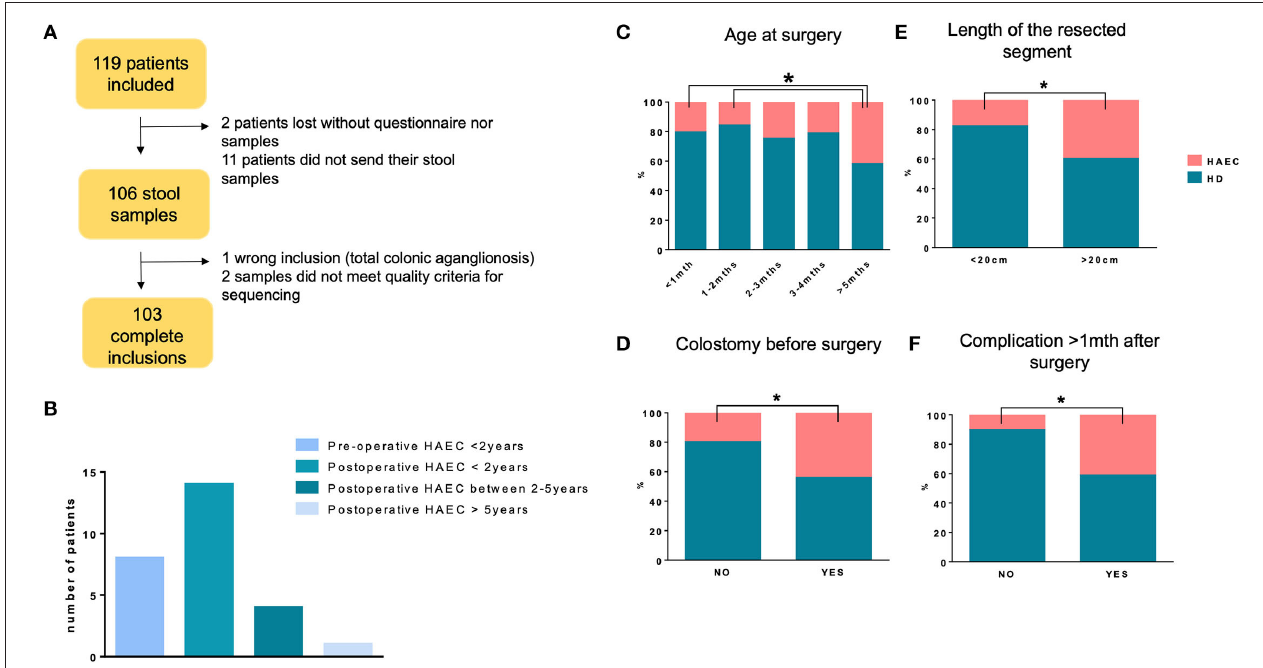
FIGURE 1 | MICROPRUNG cohort characteristics. Flowchart of the cohort (A) , Hirschsprung-associated enterocolitis incidence as a function of age (B) , age at surgery (C) , existence of colostomy before surgery (D) , length of the resected segment (E) , and occurrence of complications more than 1 month after surgery (F) . * P < 0.05 for HAEC